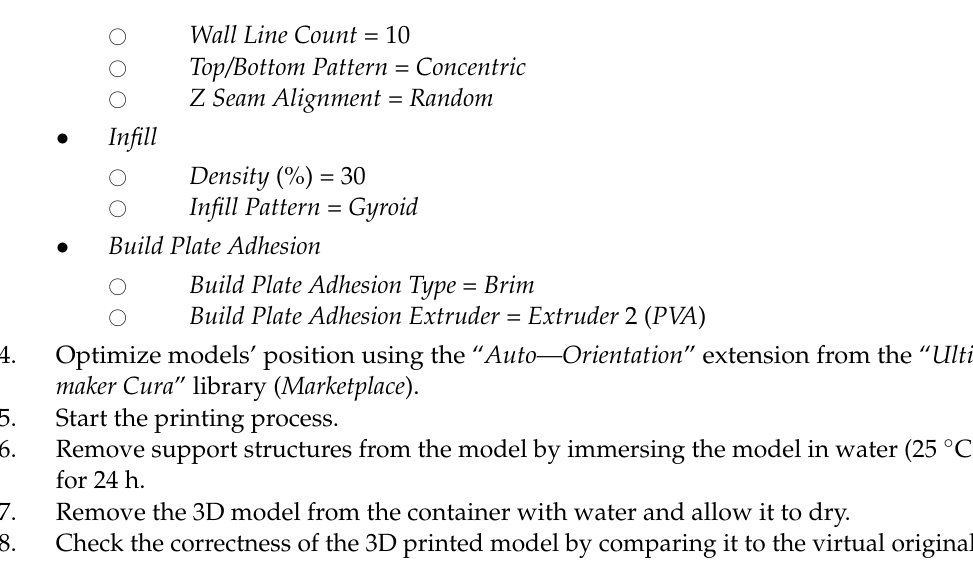
Figure 3. The structure of human foot 3D model. 1—Phalanx distalis hallucis, 2—Phalanx distalis digiti pedis secundi, 3—Phalanx distalis digiti pedis tertii, 4—Phalanx distalis digiti pedis quarti, 5—Phalanx dis- talis digiti pedis minimi, 6—Phalanx media digiti pedis secundi, 7—Phalanx media digiti pedis tertii, 8— Phalanx media digiti pedis quarti, 9—Phalanx media digiti pedis minii, 10—Phalanx proximalis hallucis, 11—Phalanx proximalis digiti pedis secundi, 12—Phalanx proximalis pedis digiti tertii, 13—Phalanx prox- imalis digiti pedis quarti, 14—Phalanx proximalis digiti pedis minimi, 15—Os metatarsus primus, 16—Os metatarsus secundus, 17—Os metatarsus tertius, 18—Os metatarsus quartus, 19—Os metatarsus quintus, 20—Os cuneiforme mediale, 21—Os cuneiforme intermedium, 22—Os cuneiforme laterale, 23—Os cu- boideum, 24—Os naviculare, 25—Talus, 26—Calcaneus, 27/28—Os sesamoideum . The next step is the validation of models’ anatomical correction with the help of t he literature [19–21]. At this stage, it is necessary to decide whether additional model editing is required. In case of a positive result, adjustments are made following the editing meth- odology in the “ Meshmixer ” program. The final step is 3D printing, which takes place in accordance with the 3D printing methodology (partly shown in Figure 4), while the printing process itself uses a 5S 3D extrusion-type printer from Ultimaker company with the following parameters: Nozzle diameter: 0.4 mm, Layer Height: 0.1 mm,